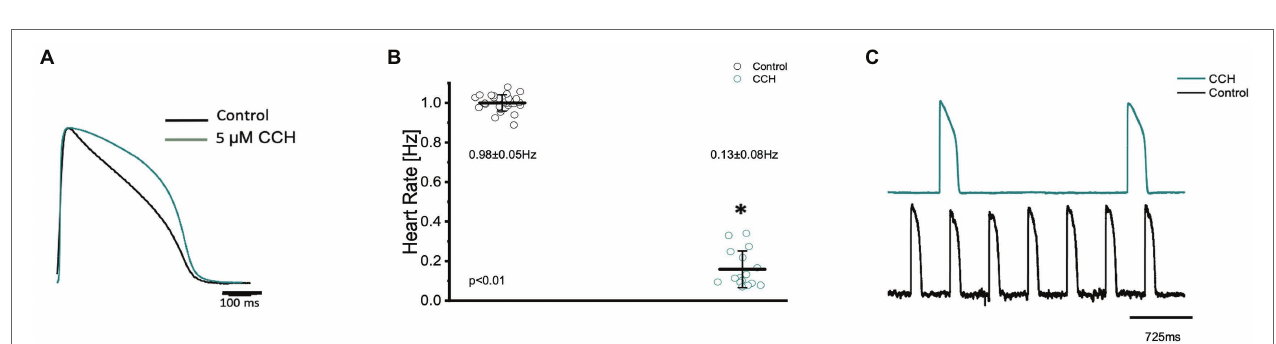
FIGURE 6 | Kinetic parameters of the Goldfish ventricular Ca 2+ transients before (black) and after (red) perfusion with 100 nm isoproterenol. Perfusion of the Goldfish heart with 100 nM isoproterenol significantly decreased the rise time (RT) of the Ca 2+ transient from 27.98 ± 4.60 ms to 22.47 ± 3.50 ms ( p < 0.01, n = 65 for the control, n = 96 for ISO, N = 8; A ), decreased the fall time (FT) of the Ca 2+ transient from 150.08 ± 22.80 ms to 135.88 ± 20.30 ms ( p < 0.01, n = 76 for the control, n = 76 for ISO, N = 8; B ), and significantly decreased the half duration (HD) of the Ca 2+ transient from 148.60 ± 8.10 ms to 134.87 ± 5.20 ms ( p < 0.01, n = 64 for the control, n = 72 for ISO, N = 8; C ). * Denotes a significant difference between the two distributions. The data are presented as multiple measurements (n; dot cloud) recorded for different measurements ( n ) on different hearts ( N ) with the mean ± SEM (solid lines).